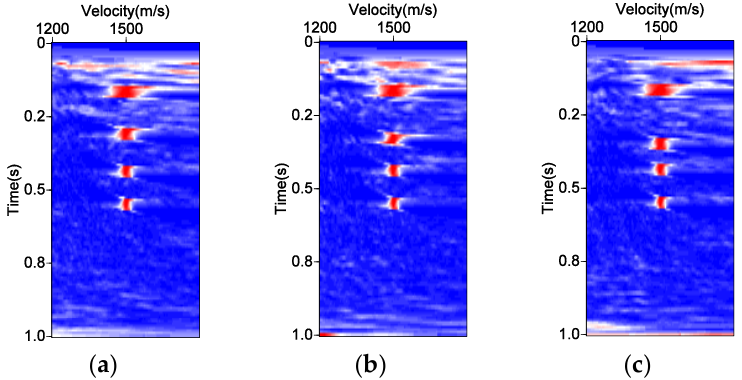
Figure 6. Velocity spectrum. ( a ) CDP 30; ( b ) CDP 50; ( c ) CDP 70.